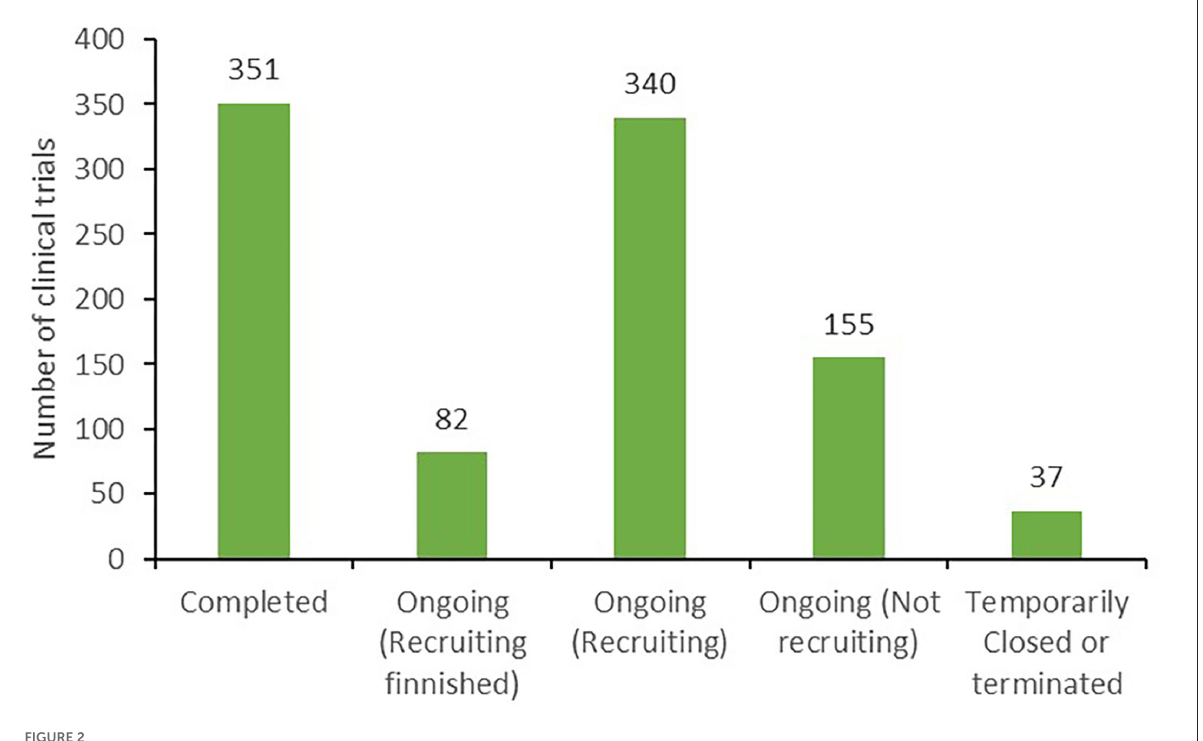
FIGURE2 Classification of the status of clinical